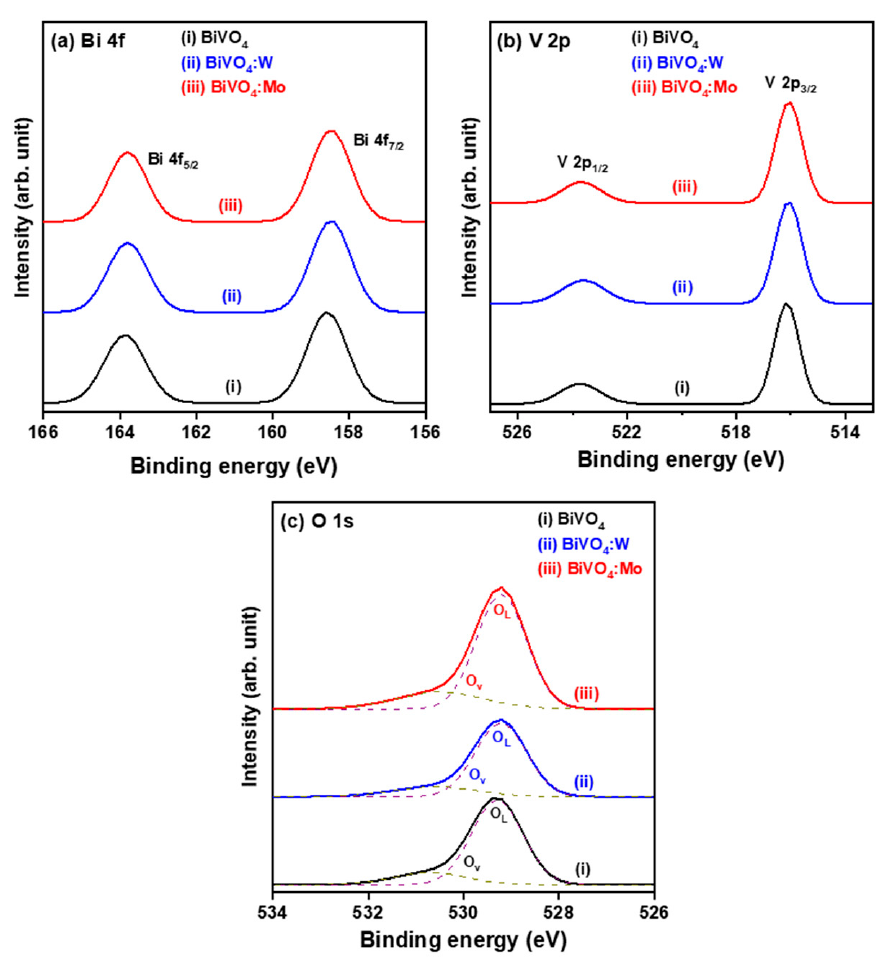
Figure 3. Core-level XPS spectra of ( a ) Bi 4f, ( b ) V 2p, and ( c ) O 1s regions of three BiVO 4 -based powder samples.